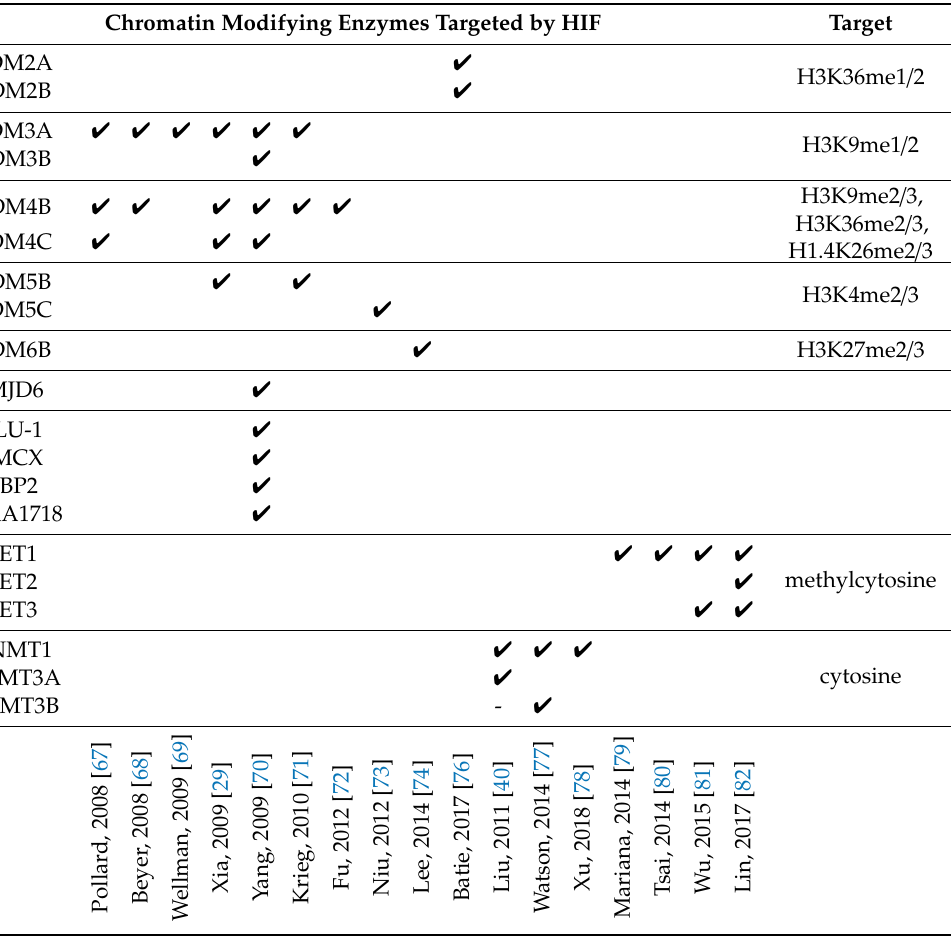
Table 2. Chromatin modifying enzymes that are direct transcriptional targets of HIF. Histone and DNA modifying enzymes that are directly regulated by the HIF transcription factors and the specific modification they add or